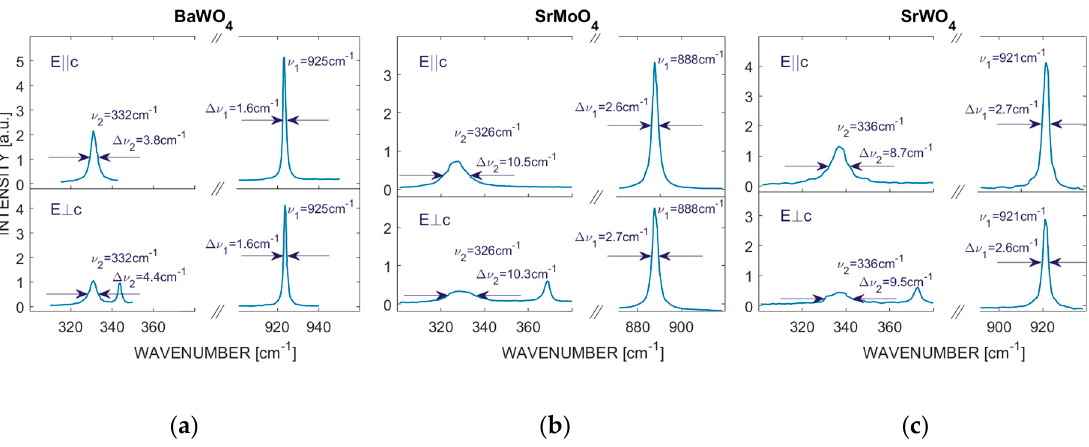
Figure 1. Polarized spontaneous Raman scattering spectra of the vicinities of the ν 1 and ν 2 lines in BaWO 4 ( a ), SrMoO 4 ( b ) and SrWO 4 ( c ) crystals at exciting light polarization parallel ( E ‖ c ) and perpendicular ( E ⊥ c ) to the crystal optical axis.